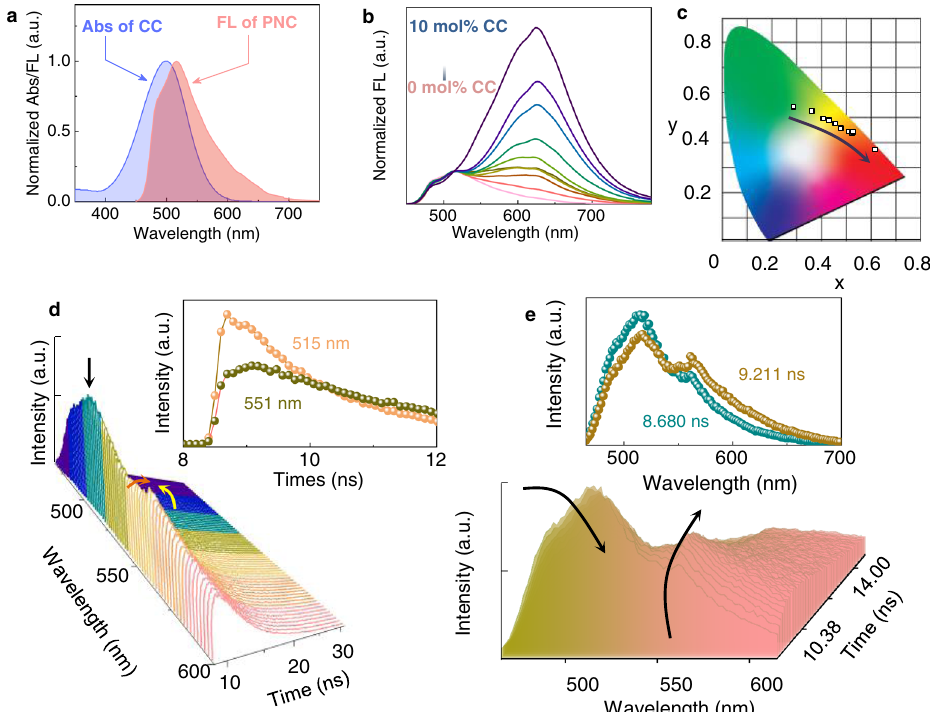
Fig. 4 Optical properties of assemblies upon THF/H 2 O = 3/7 (v/v). a Normalized spectrum overlaps of donor emission (10 − 4 M) and acceptor absorption (2 × 10 − 4 M, excited at 430 nm). b Normalized fl uorescent emission of PNC (2 × 10 − 4 M) with various amount of CC (0, 0.1, 0.3, 0.5, 0.7, 1, 3, 5, 7, 10 mol%, excited at 430 nm) and c corresponding CIE coordination. d Fluorescent decay curves of PNC/CC ([CC] = 10 − 6 M). Inset shows fl uorescent decay curves of PNC/CC at emission wavelengths of 515 and 551 nm. e TRES of PNC/CC ([CC] = 10 − 6 M). Inset shows TRES at 8.680 and 9.211 ns, respectively (excited at 441 nm) ([PNC] = 2 × 10 − 4